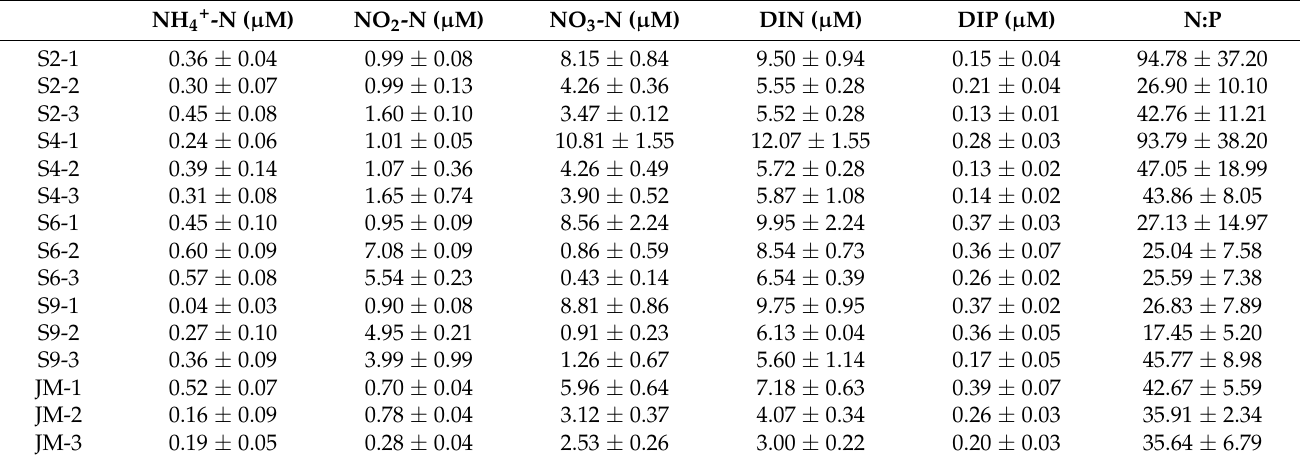
Table 1. Dissolved inorganic nitrogen (DIN), inorganic (DIP) and N:P (the ratio of DIN to DIP) assay in different aquafarm